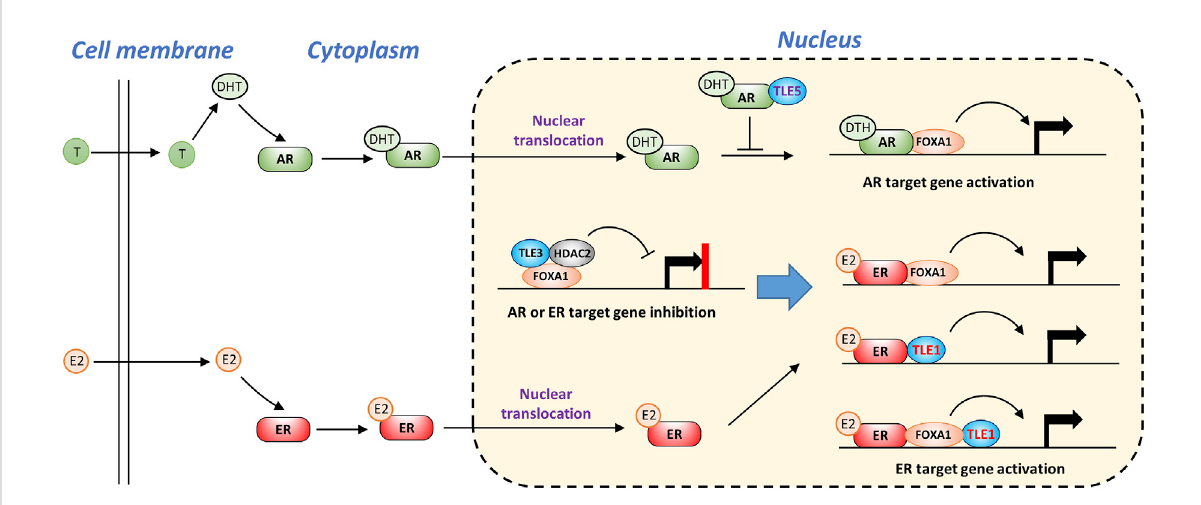
FIGURE 5 TLEsregulateARandERligand-dependentsignalingpathways.Withoutligandstimulation,TLE3isrequiredtopreventinappropriateexpression of AR or ER target genes. Upon ligand stimulation, TLE1 functions as a coactivator of ER target gene expression by interacting with ER and FOXA1. TLE5 suppresses AR target gene expression by interfering with AR-DNA